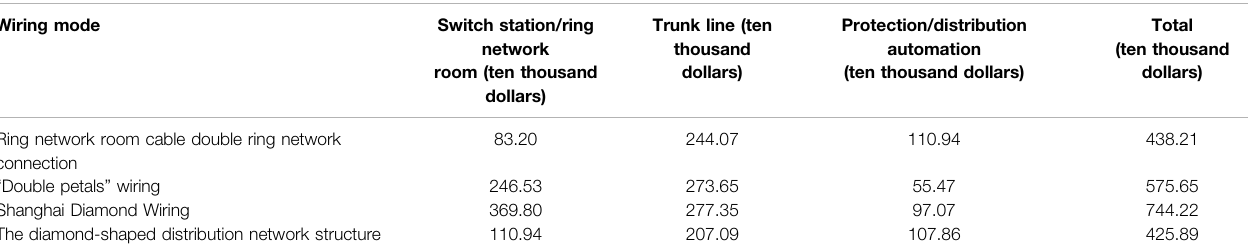
TABLE 2 | Economic analysis of newly-built typical power supply grid.